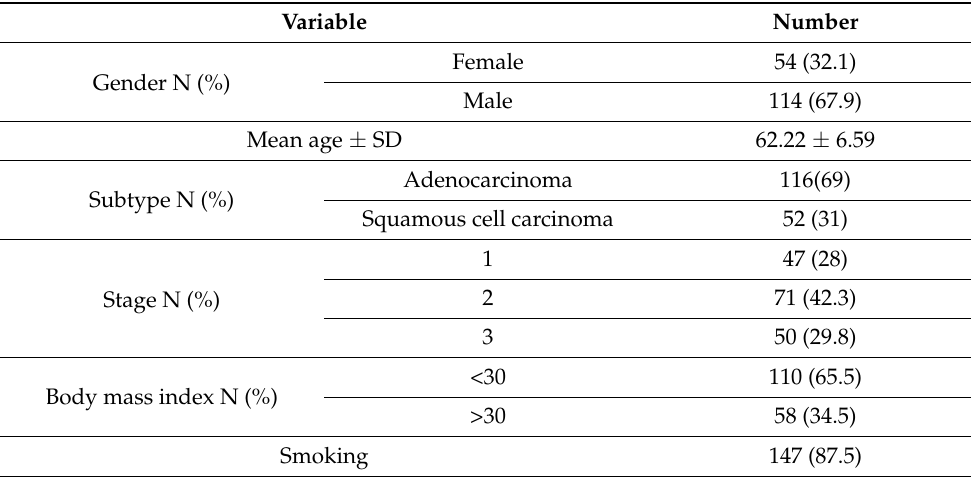
Table 1. The frequency of demographic data of study